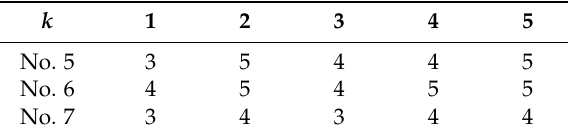
Table 2. Regeneration cycle number.